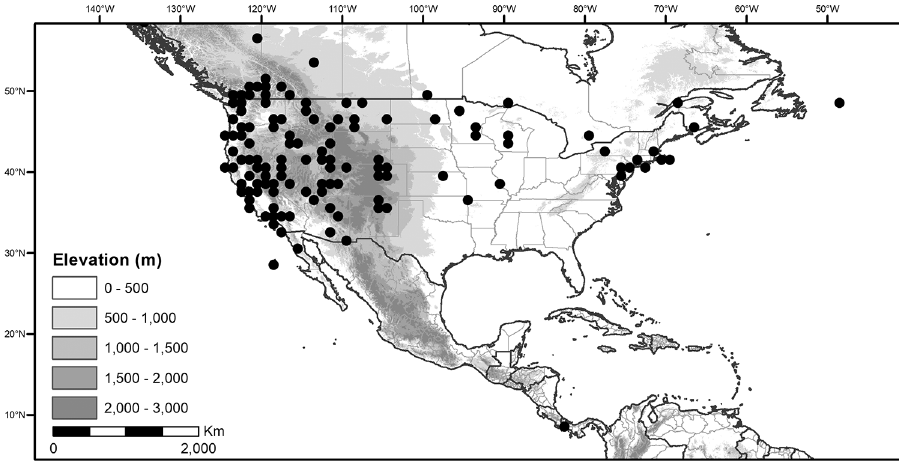
Figure 35. Distribution of Solanum nitidibaccatum